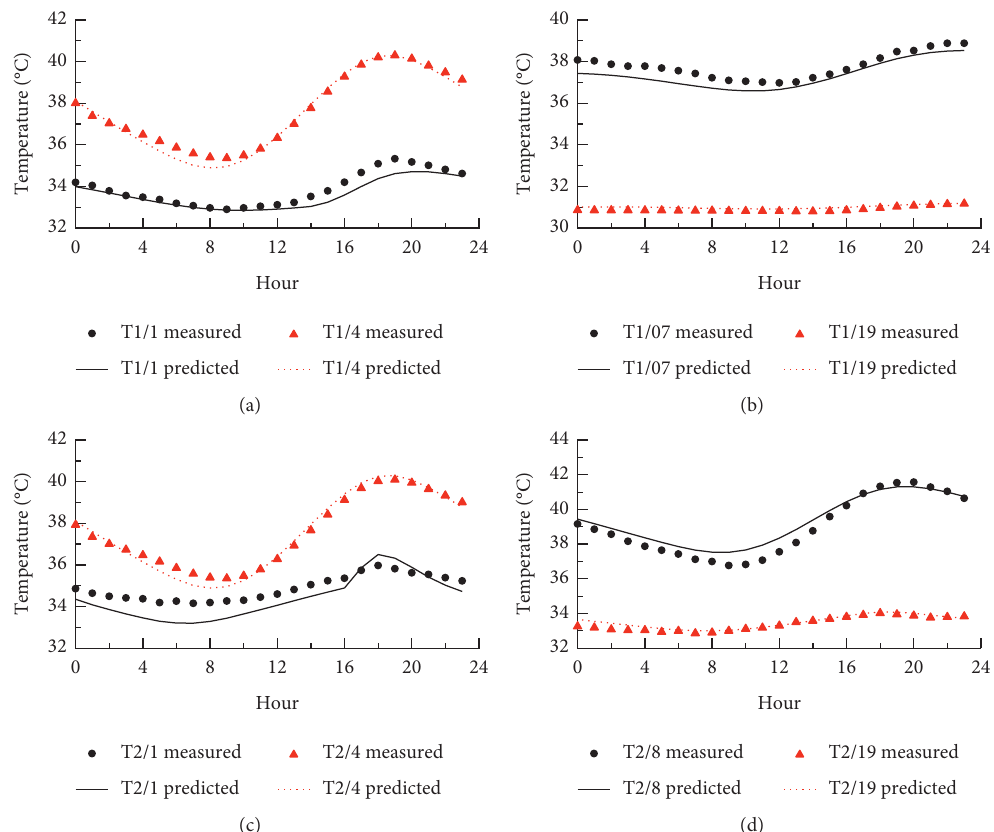
Figure 10: Comparison of the measured and predicted temperatures: (a) T1/2 and T1/4, (b) T1/7 and T1/19, (c) T2/2 and T2/4, and (d) T2/8 and T2/19.